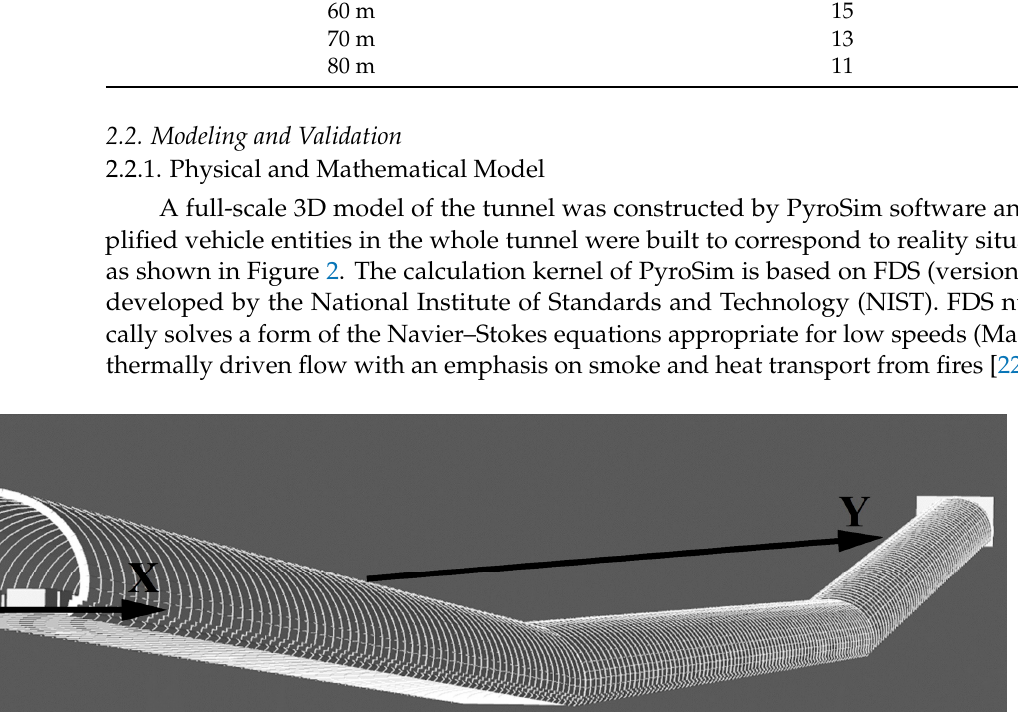
Table 2. Schemes of tunnel slide spacing.